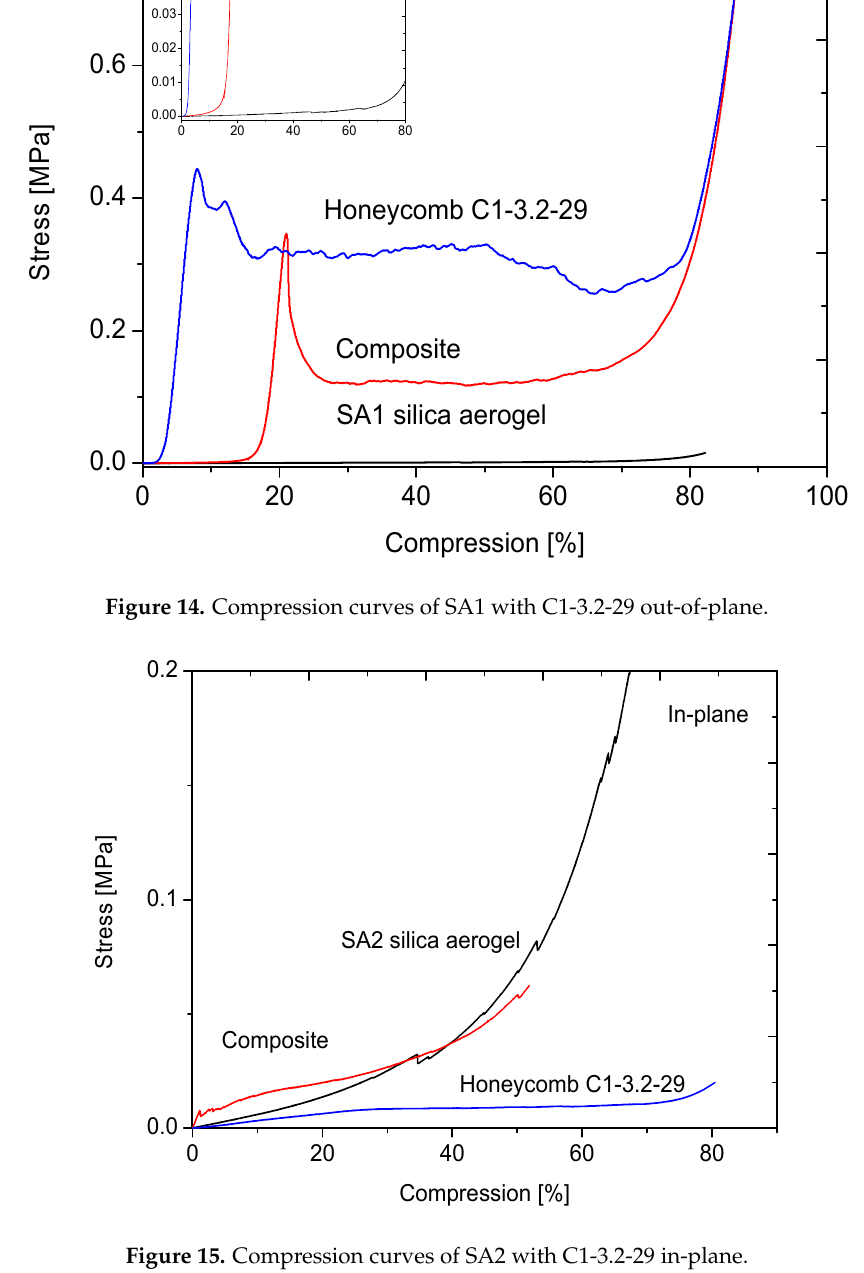
Figure 15. Compression curves of SA2 with C1-3.2-29 in-plane.